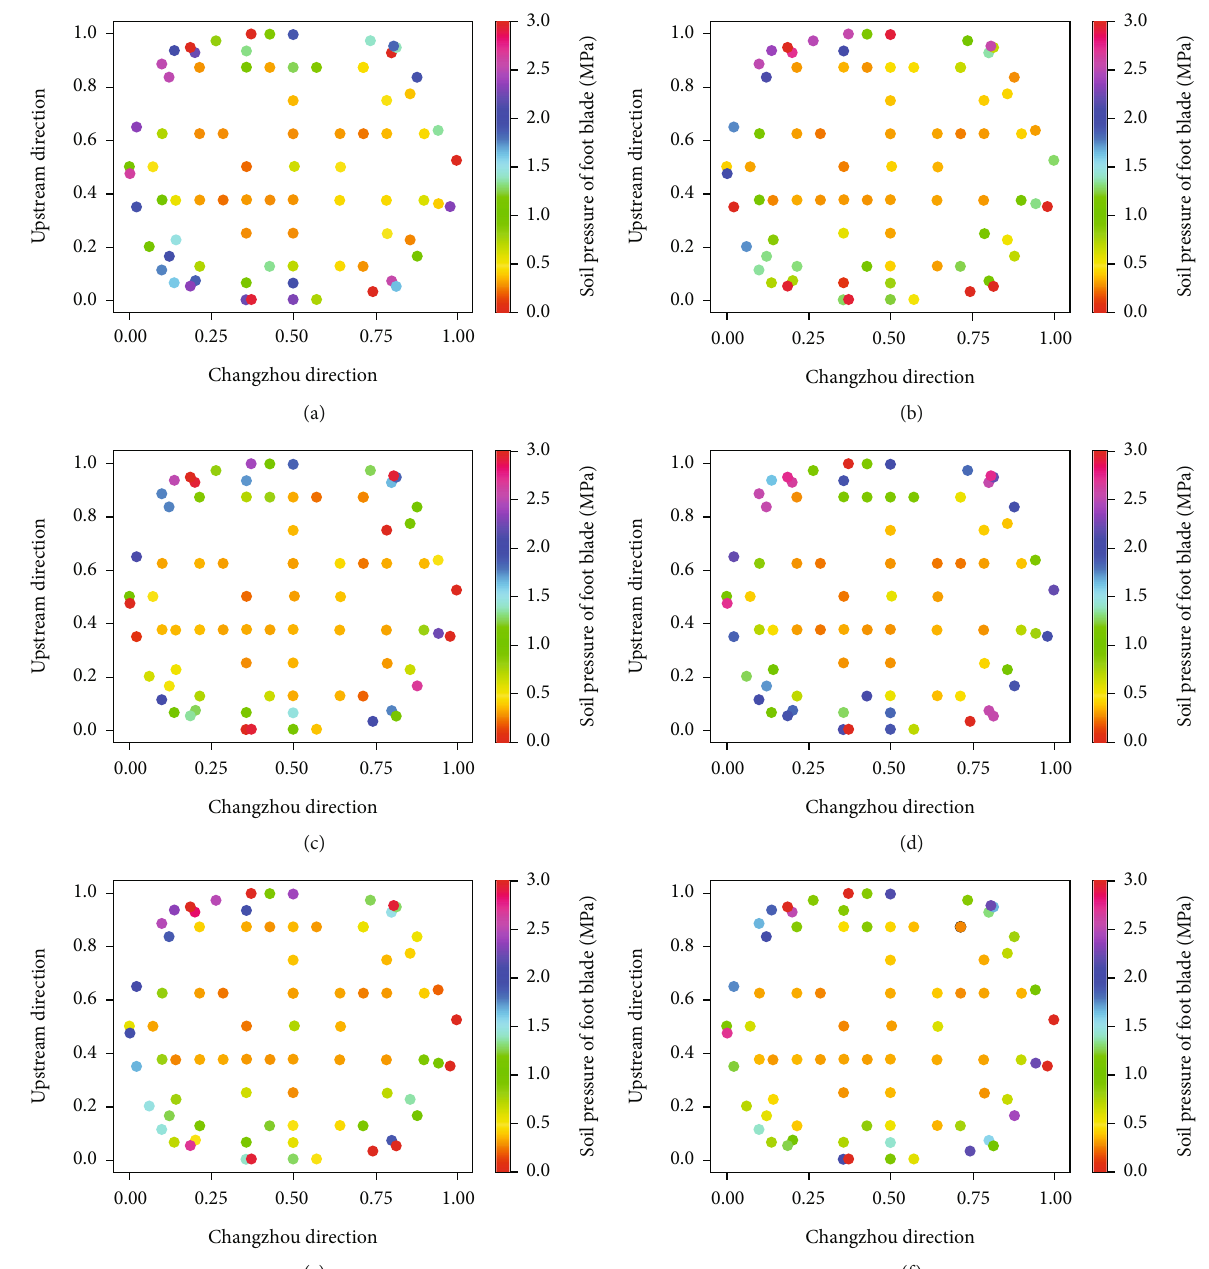
Figure 10: Real and predicted values of the model at di ff erent moments in time. (a) July 30, 2020 20: 00 real value; (b) August 3, 2020